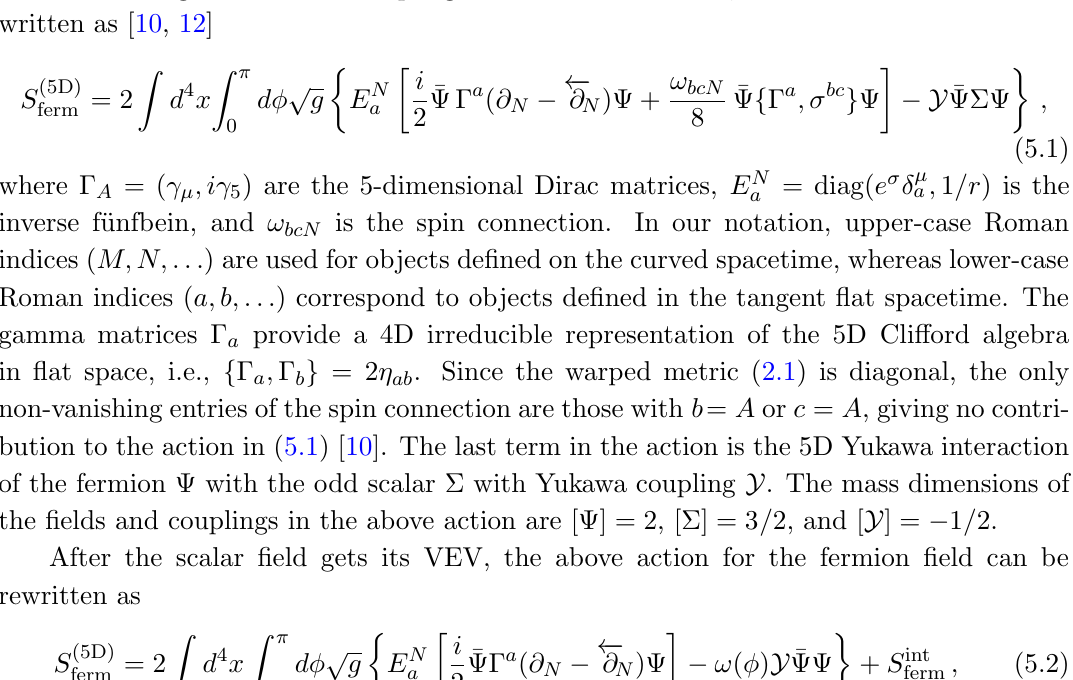
Table 2 . Main branching ratios for the (cid:12)rst KK resonance of the Z under consideration. Last two columns show the values of m S and m T while m Q the cases shown, see main text for more